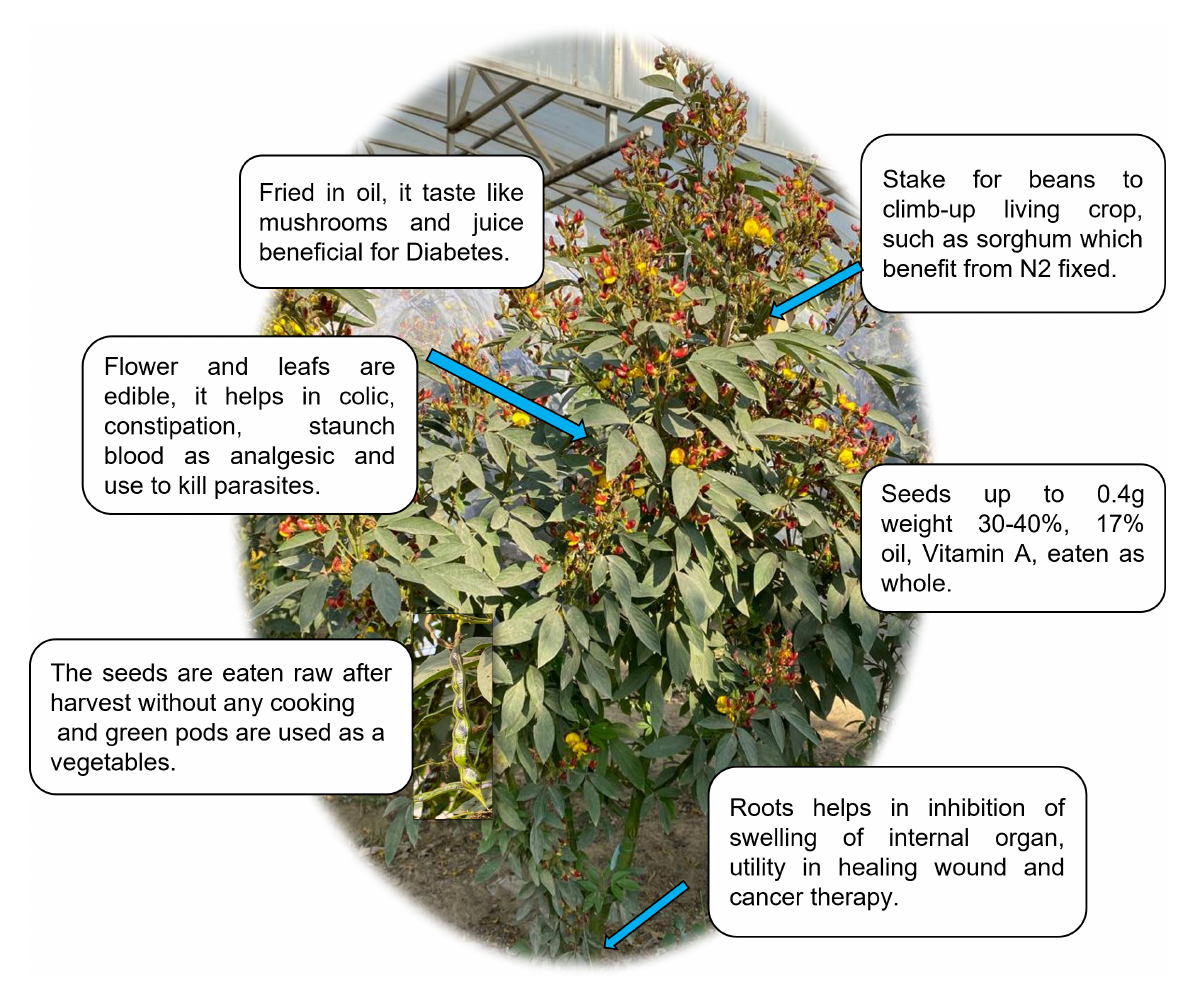
FIGURE2 Different bioactivities of the legumes. A summary of the legume plant (pigeonpea): A multifunctional crop containing roots, seeds, and leaves that can be used in a variety of